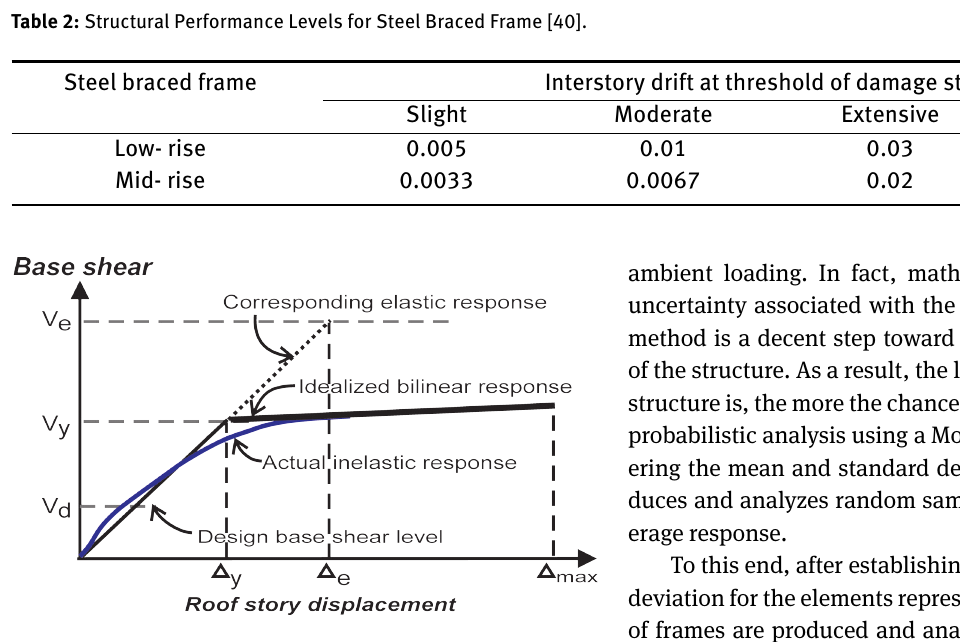
Figure 4: lateral load-roof displacement relationship